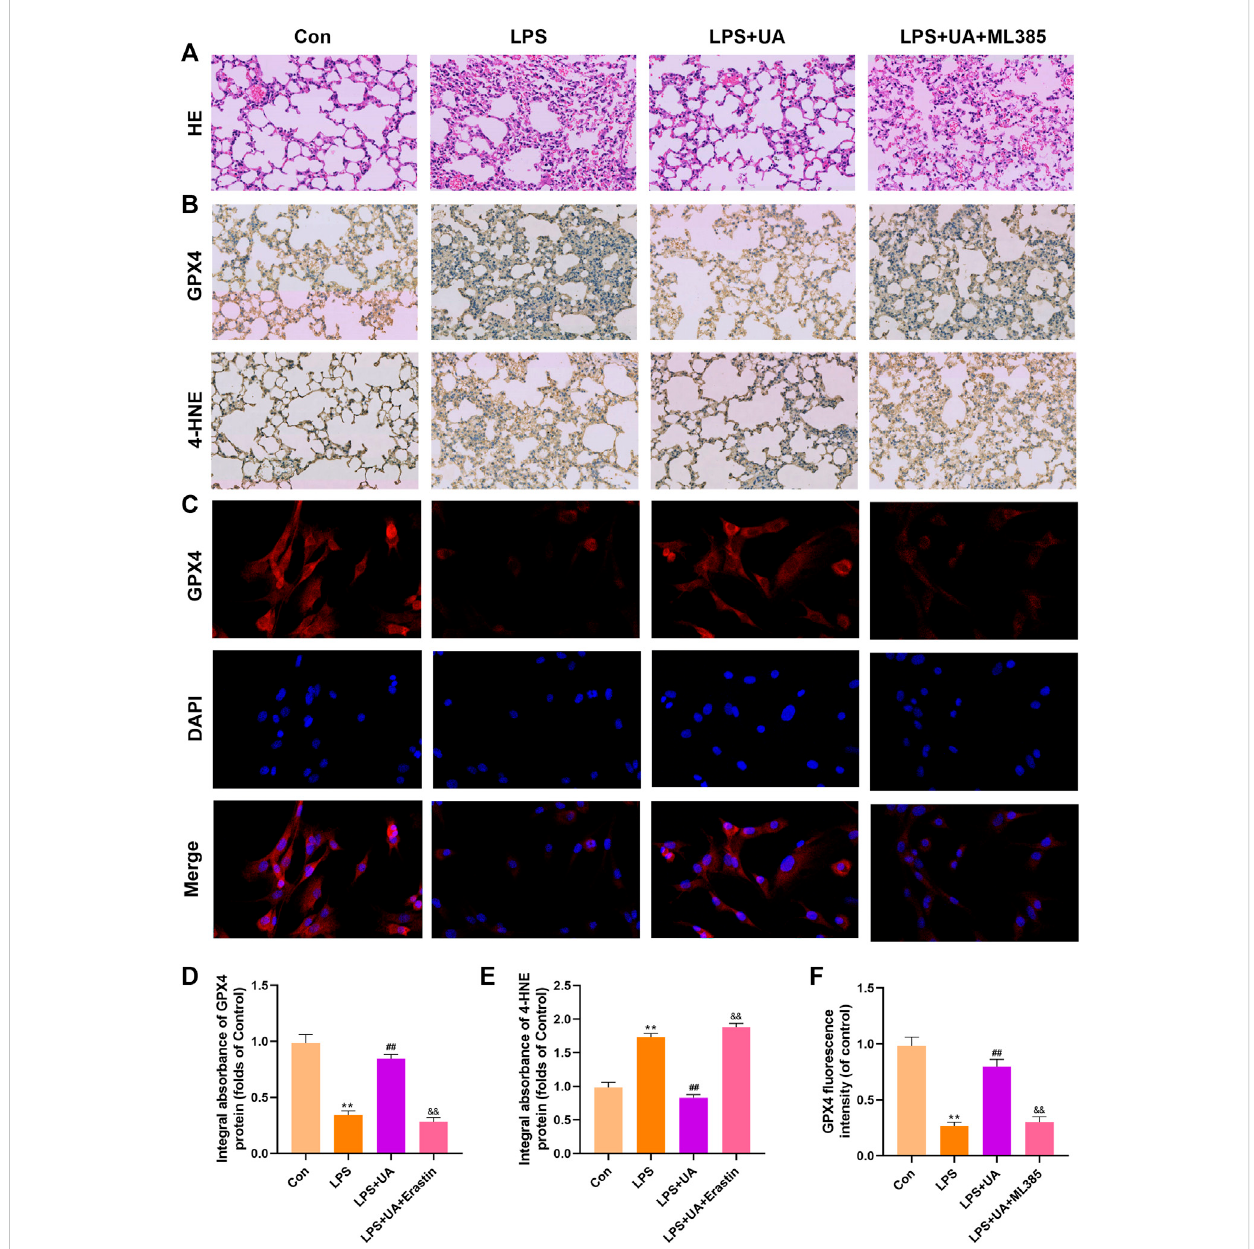
FIGURE 7 Urolithin A (UA) inhibited ferroptosis by activating Nrf2. (A) Typical images showed the H&E staining in lung tissue. (B,D,E) A typical IHC image showed the GPX4 and 4-HNE expression in lung tissues. (C,F) Typical IF images showed GPX4 expressionin BEAS-2B cells. The results wererepresented by mean ± SD. ## p < 0.01, ** p < 0.01, && p < 0.01 in comparison to control, LPS and LPS + UA groups,